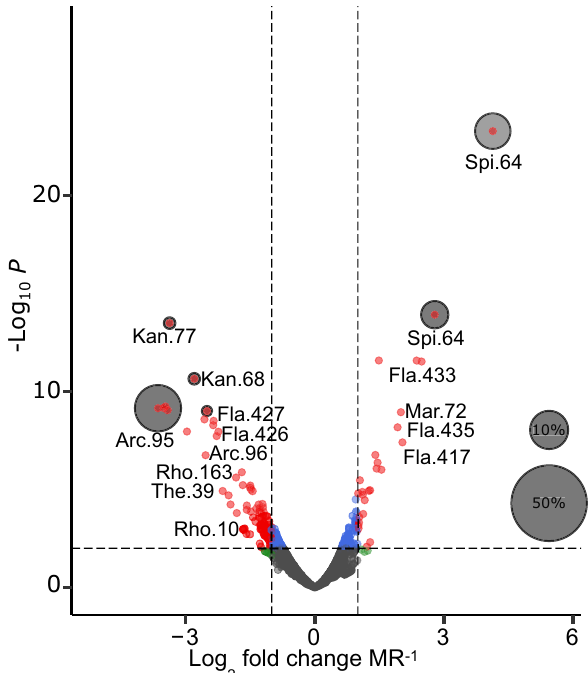
Figure 2. Volcano plot of DESeq2 results showing the ASVs identified to the family level that were significantly affected by MR. Significant P values were set at Padj < 0.01. Log2 fold changes are standardised to one unit of change in MR. Red points are those with a Padj < 0.01 and Log2 fold of > 1. Grey circles indicate the relative abundance of ASVs, the top ASVs of interest have been